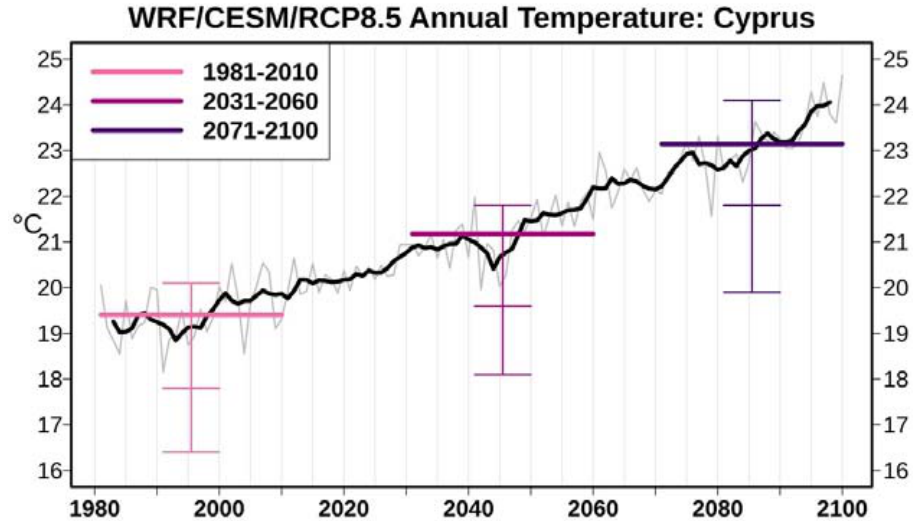
Figure 5. Simulated mean temperature (grey), 5 ‐ year moving average (black), 30 ‐ year averages (colored), and median and range of 26 EURO ‐ CORDEX simulations (error bars), over Cyprus.